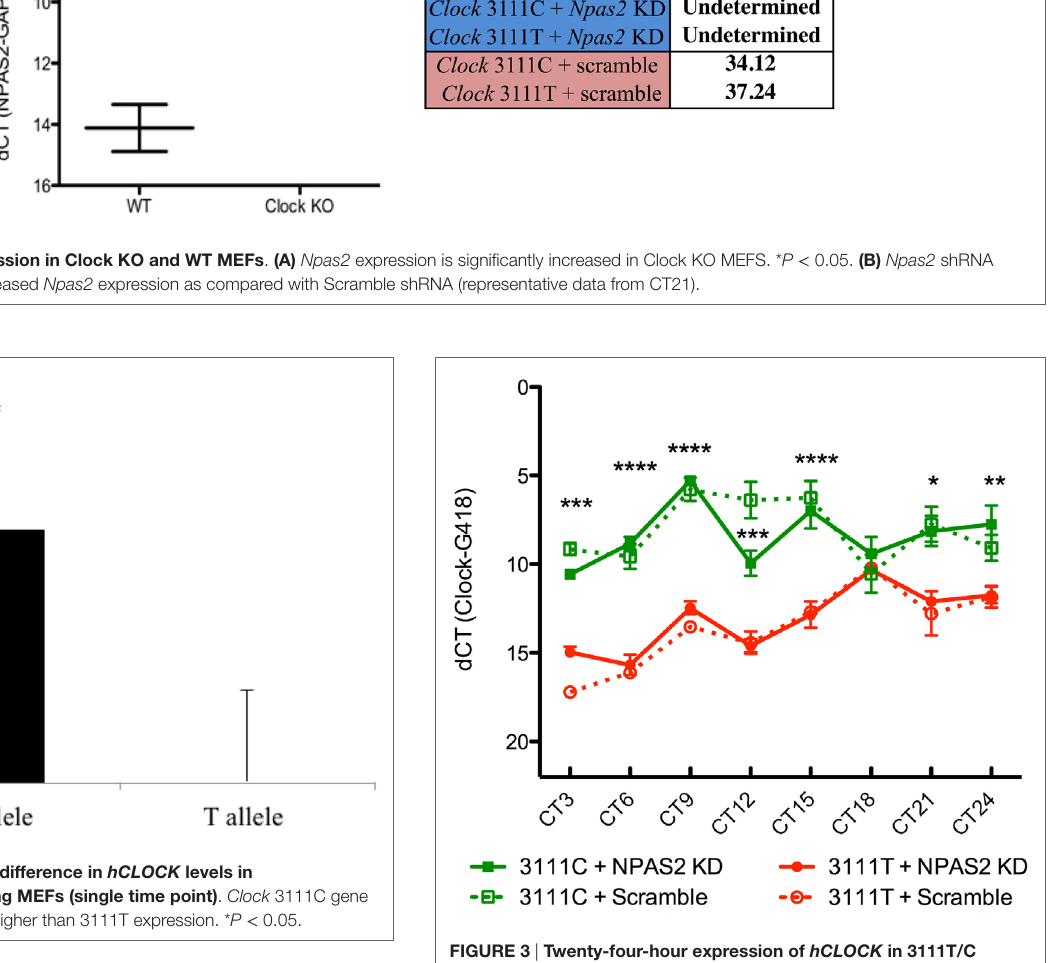
FigUre 3 | Twenty-four-hour expression of hCLOCK in 3111T/c snP-expressing MeFs . Clock 3111C gene expression over 24 h is significantly higher than Clock 3111T expression. **** P < 0.0001, *** P < 0.001, ** P < 0.01, * P < 0.05.